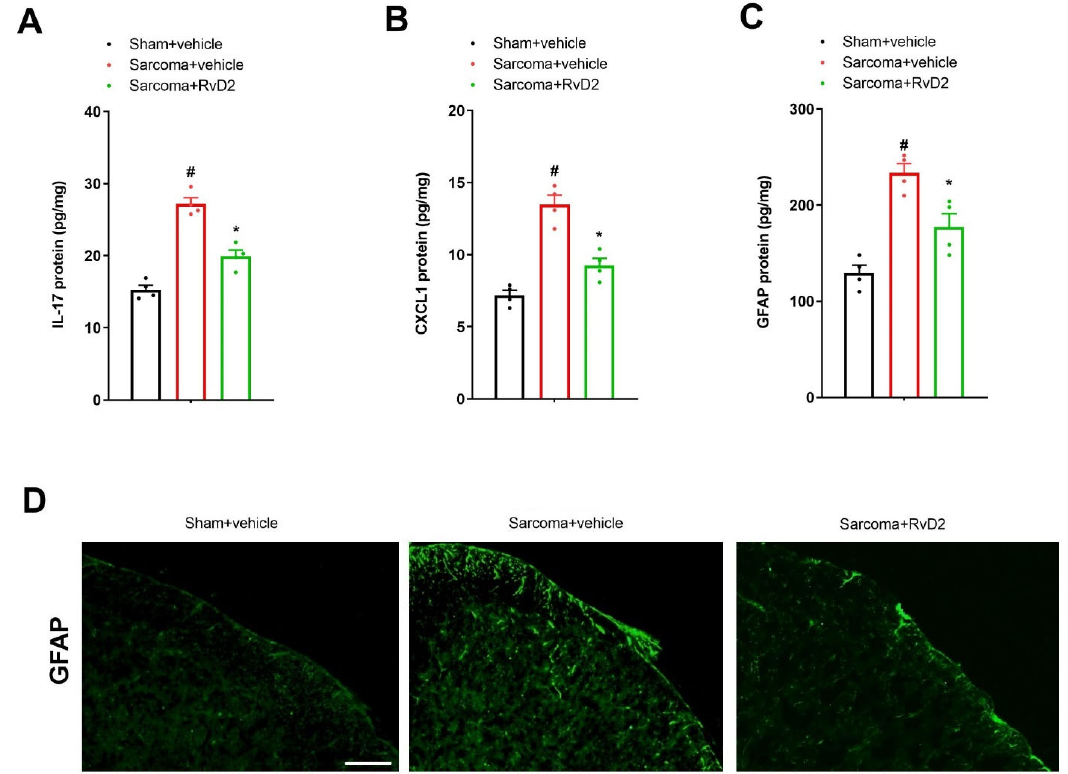
Figure 4. Pretreatment with RvD2 reduced spinal IL-17 secretion, CXCL1 release and astrocyte activation in animals with bone cancer pain. Intrathecal RvD2 (500 ng) was given daily on days 4, 5 and 6 following sarcoma cell implantation. All data from biochemical experiments were collected on day 7 following sham and sarcoma implantations. ( A – C ) ELISA assay showed that RvD2 pre- treatment down-modulated the elevated levels of spinal IL-17, CXCL1 and GFAP (the marker of astrocyte activation) proteins in sarcoma animals. ( D ) Immunohistochemistry staining showed representative photomicrographs of spinal GFAP following sarcoma interventions and RvD2 exposure (scale bar, 50 μ m). Results from biochemical experiments are presented as the mean ± SEM ( n = 4) and compared using one-way ANOVA followed by Bonferroni multiple comparisons. # p < 0.05 vs. group sham + vehicle. * p < 0.05 vs. group sarcoma + vehicle.